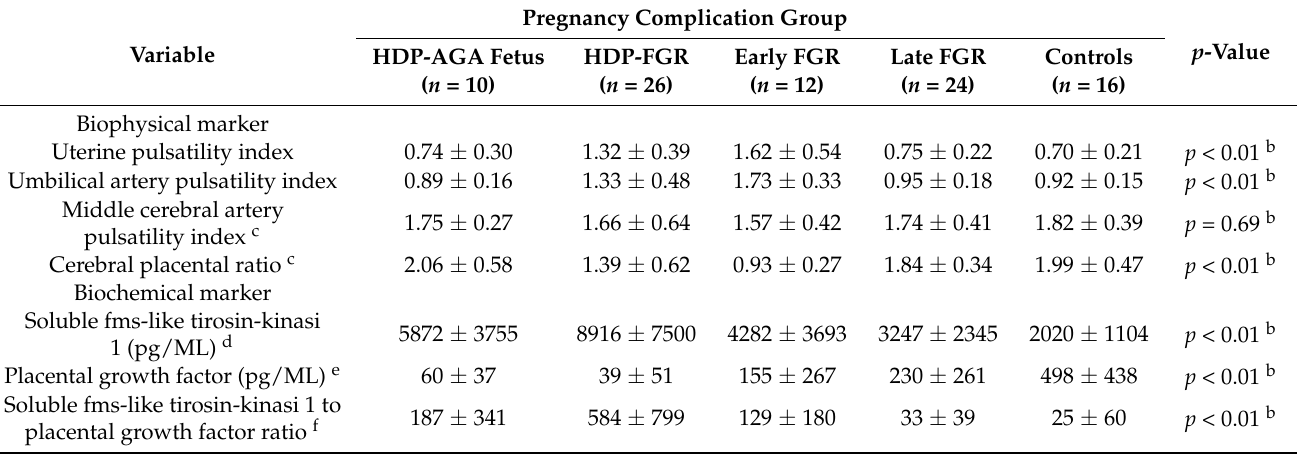
Table 3 reports placental characteristics according to Amsterdam classification system of placental